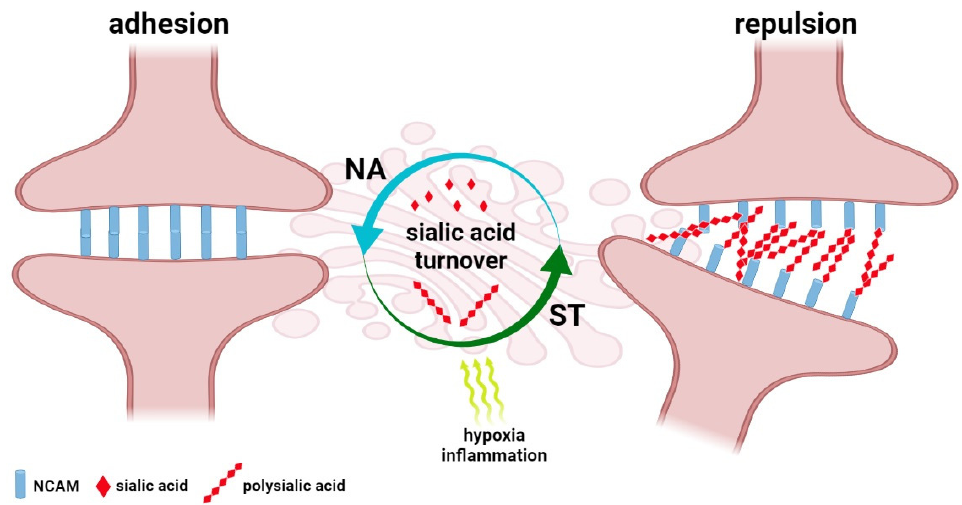
Figure 3. The regulatory function of polysialic acid turnover in the brain. Polysialic acid (PSA) is a linear homopolymer of a 2,8-linked sialic acid that forms a sugar chain with steric properties due to a high density of negative charges. At the posttranslational level, NCAMs are modified through attachment of PSA in the Golgi compartment by typical mechanism of N-linked core glycosylation. In result, the 2,8-linked sialic acid prevents homophilic interactions between synaptic NCAMs and their heterophilic interactions with homologous ligands. These alteration in the brain are accompanied by an increase in the number of PSA-NCAM immunoreactive neurons that results in the modification of synapse density in response to degenerative factors, including inflammation and hypoxia.